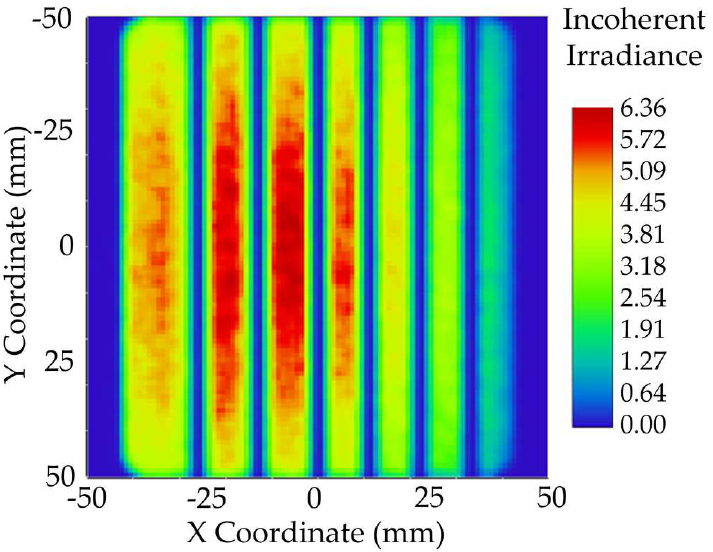
Figure 6. A heat map of simulated light escaping from the reaction chamber.